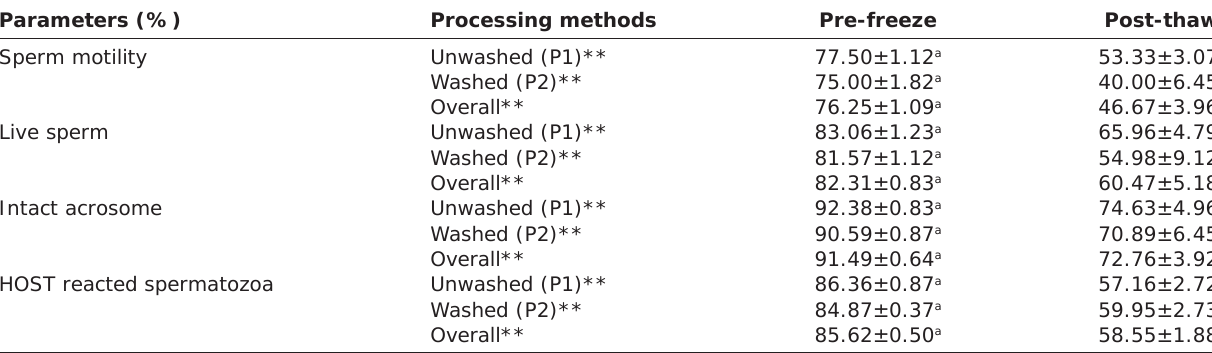
Table-3: Quality parameters in washed and unwashed sperm samples at pre-freeze and post-thaw (mean±SEM). Parameters